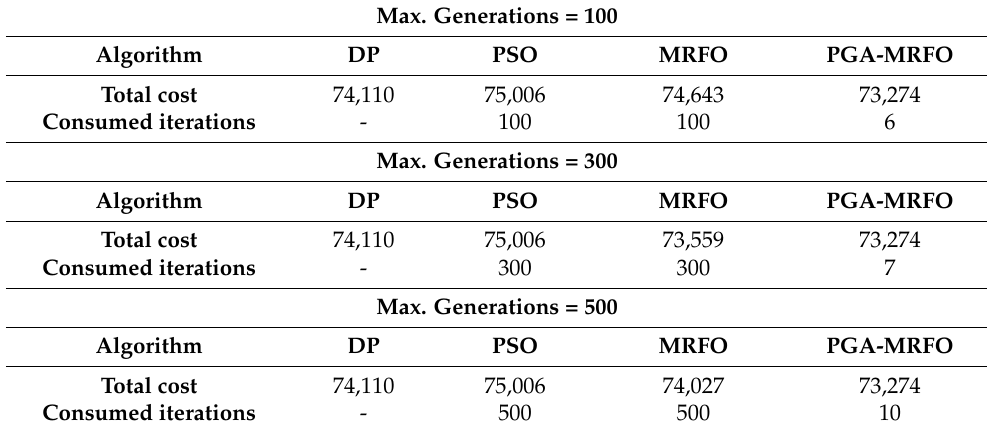
Table 5. Results of the four algorithms for the UC problem—Case 1 with a constant population size of 100.